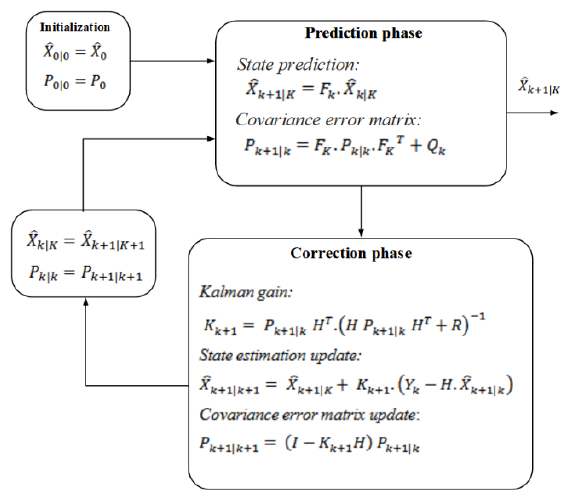
Figure 5. Extended Kalman filter (EKF) algorithm equations.